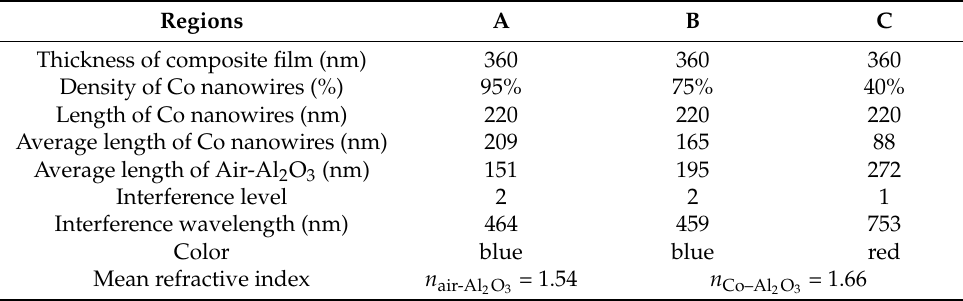
Figure 7. The structural models of alumina-Co composite film. Parts ( a – c ) corresponding to positions A to C in Figure 4c; ( d ) The schematic diagram of composite film interference. Table 2. The parameters of different regions shown in Figure